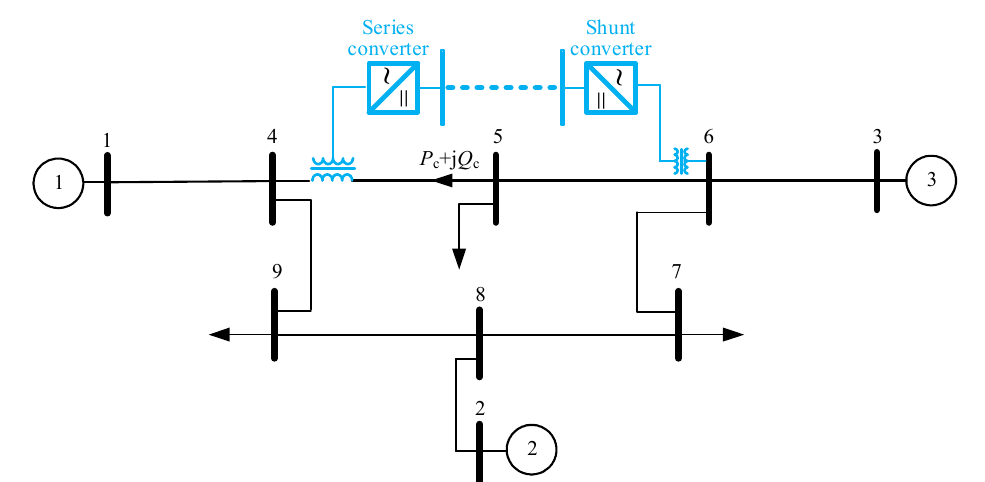
Figure 4. The Western System Coordinating Council (WSCC) 9-bus test system with the general structure UPFC.